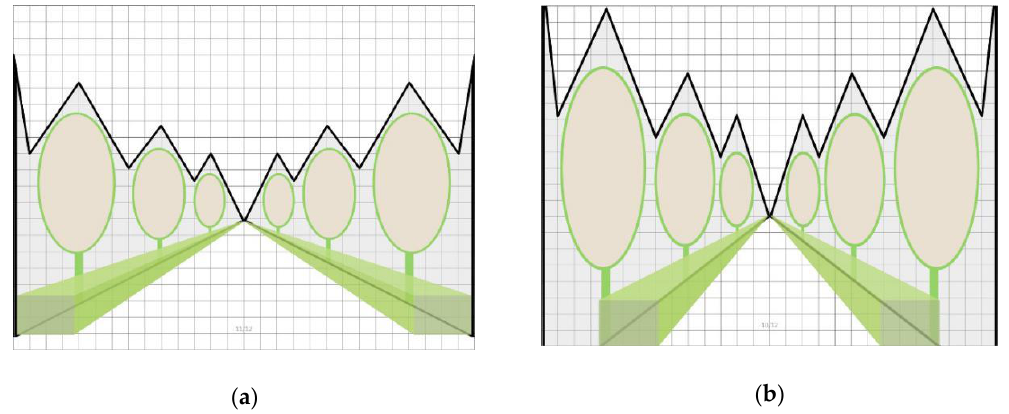
Figure 10. Taking the simplest planting method as an example: ( a ) vegetation pattern minimum; ( b ) vegetation pattern maximum.